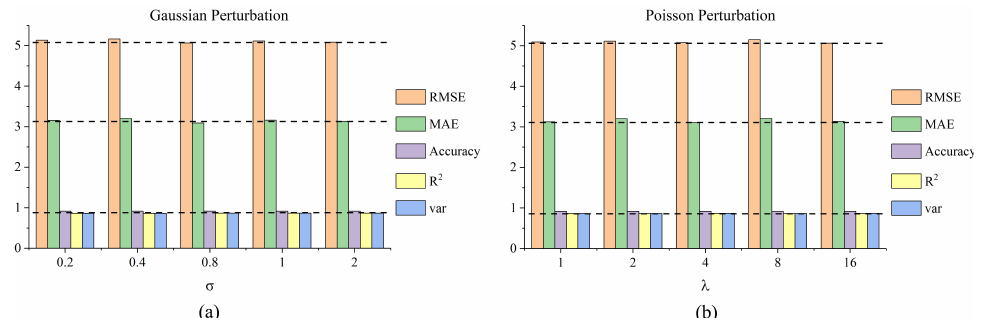
Figure 7. Los-loop: Perturbation analysis. ( a ) The performances of the A3T-GCN after adding Gaussian perturbation to the Los-loop dataset. ( b ) The performances of the A3T-GCN after adding Poisson perturbation to the Los-loop